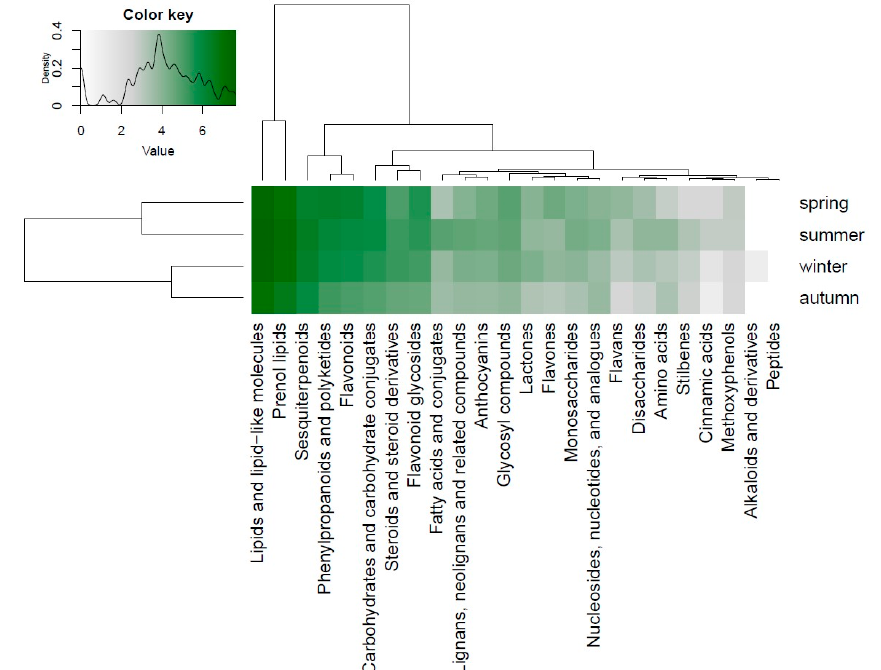
Figure 4. The heatmap shows the richness in the compound classes and the relationship to the study factor seasons. The intensity of the green color corresponds to the number of chemical entities. The color key represents the legend of the heatmap plot and shows the density distribution of counts throughout the range of values which is represented by white (no counts) and green (many counts) colors at a logarithmic scale.